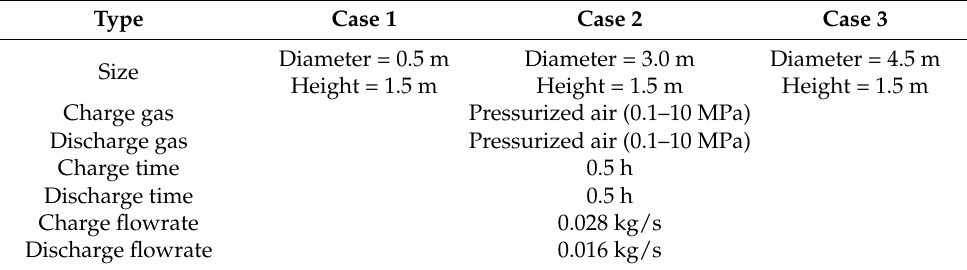
Table 3. Three cases for the dynamic simulation of the